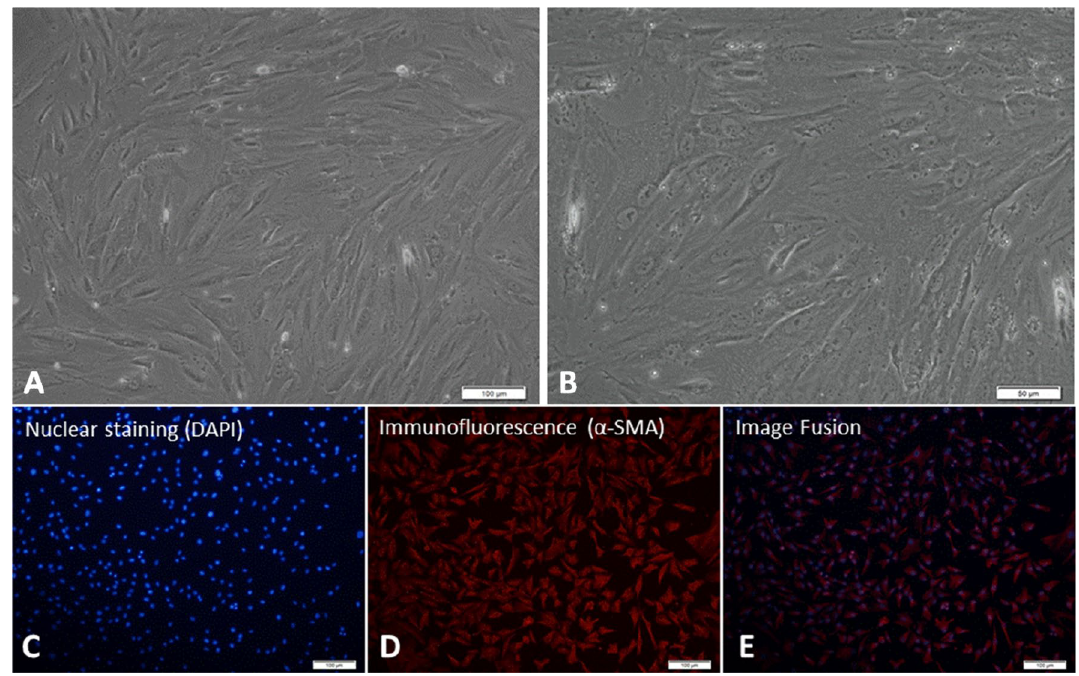
Figure 3. ( A ) Primary HSCs isolated from BA patients showed typical morphology (100×) after 3 days of culture. ( B ) Local magnification shows intracellular lipid droplets (200×). Expression of α-SMA in primary HSCs of BA was detected by immunofluorescence assay. ( C ) Nuclear staining (DAPI). ( D ) Cytoplasm showed red fluorescence indicating positive α-SMA expression. ( E ) Fusion images: the positive rate of α-SMA was 97% after counting.